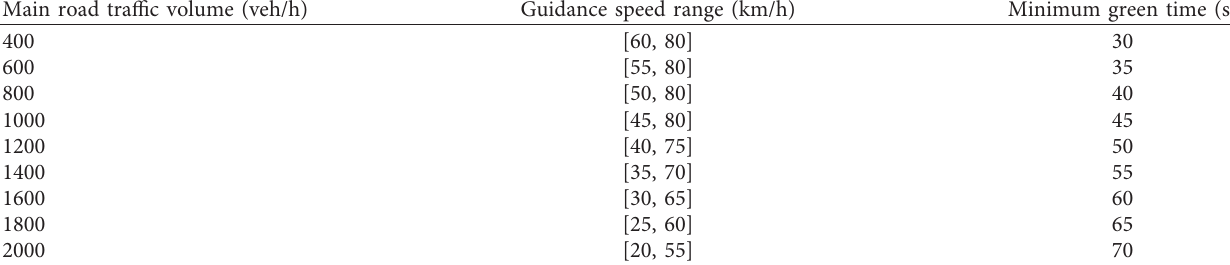
Table 2: Control parameters.